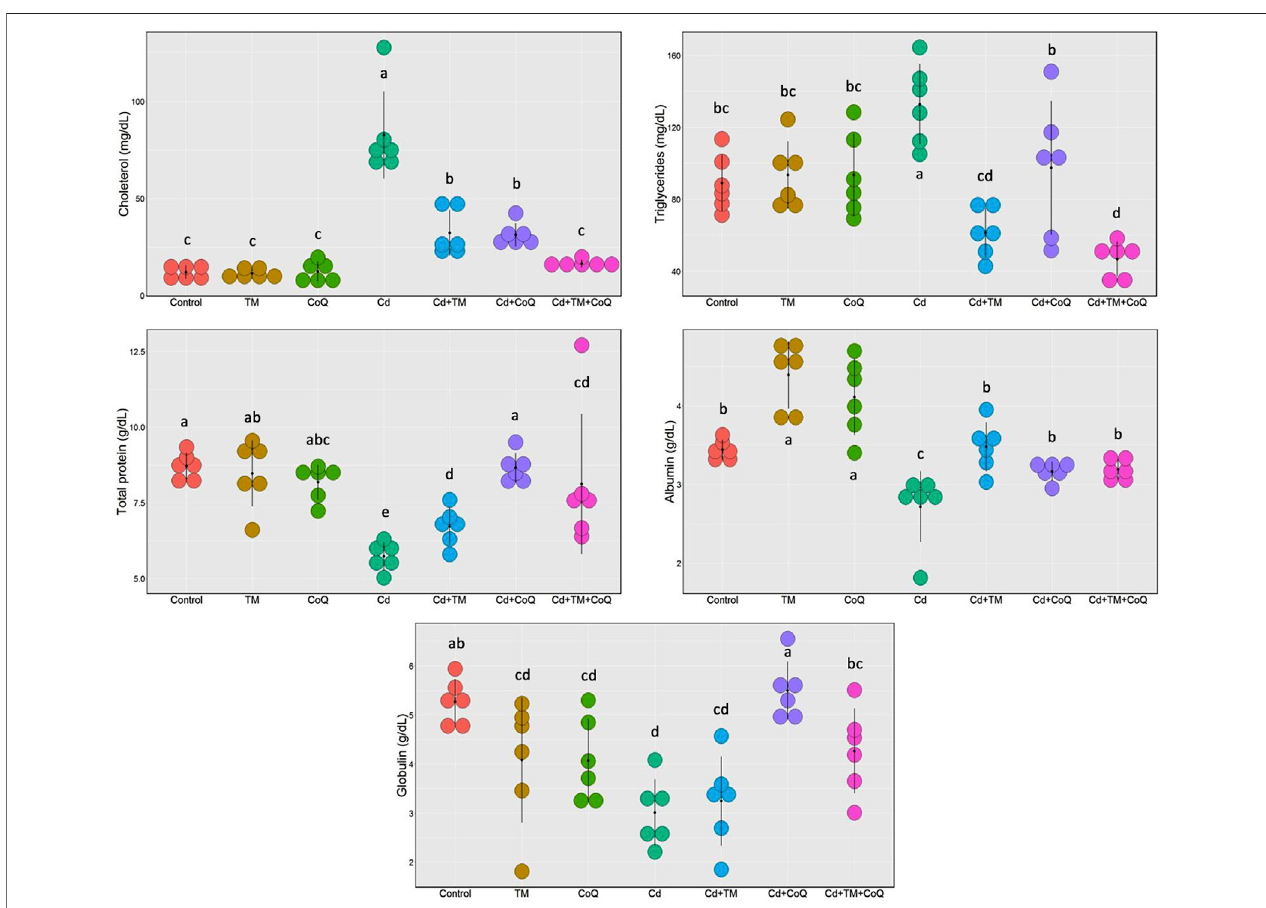
FIGURE 3 | Dot plot of serum proteins and lipid pro fi le following Cd, TM, and CoQ treatment. Cd, cadmium; CoQ, coenzyme Q10; TM, Tamarindus indica . Data presented as mean ± SD ( n = 6).